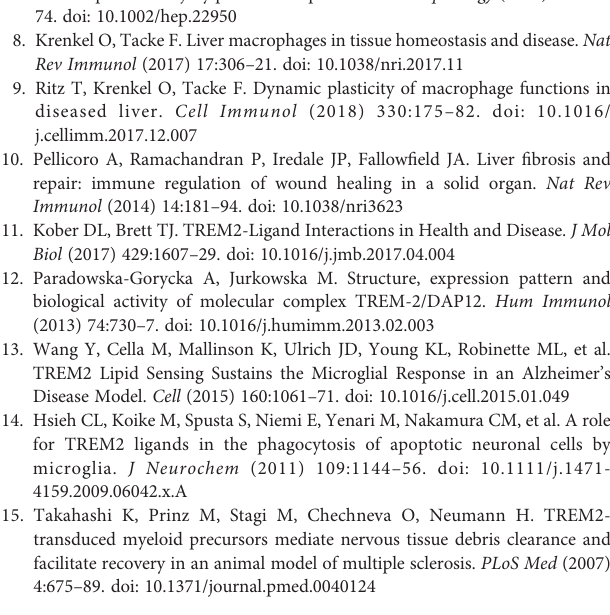
show enrichment in GFP+ cells compared to non-transferred mice in different macrophage populations: RLM, Transition and Kupffer cells. Supplementary Figure 4 | Accumulation of CD45neg SSChi cells correlates with expression of pro-in fl ammatory cytokines in the liver. Positive correlation between frequency of CD45neg SSChi population and TNF a gene expression in liver non- parenchymal cells during recovery from chronic injury (CCl4-D3). Statistics: Pearson ’ s correlation test. Supplementary Figure 5 | FACsort-puri fi ed macrophage populations and CD45neg SSChi cells for transcriptomic analysis. Wild-type and Trem-2 KO mice received a single intraperitoneal injection of APAP and macrophage populations and CD45neg SSChi cells were sorted at APAP-D3 and in control mice. Macrophage populationswereidenti fi edusingCD45,Ly6c,CD11bandF4/80markersandthepurity ofeachpopulationaftersortingisshown (A) . CD45neg SSChipopulationwas identi fi ed usingCD45markerinAPAP-D3andincontrolmiceandthepurityaftersortingisshown (B) . Each sample for transcriptomic analysis was obtained from pools of 4 mice. Supplementary Figure 6 | Heatmaps of DE-genes representing hierarchical clustering of macrophage and CD45neg SSChi cell populations. Heatmap represents 100 KCs associated genes42 for different macrophage populations (A) . Heatmap showingdifferentially expressed (DE) genes in CD45neg SSChi cells using KCs as reference: 821 genes upregulated in APAP-D3, 117 upregulated in control and 428 common to APAP-D3 and control as identi fi ed in Figure 2 .6A (B) . Supplementary Figure 7 | Gene expression and transcriptomic analysis of macrophage populations. Hmox1 and Fth1 gene expression was evaluated by qPCR in sort-puri fi ed KCs, transition and RLM populations from wild-type and Trem-2 KO mice at APAP-D3 (A) . Volcano plots representing differential expressed (DE)genes(q<0.05)between RLMandRHMinwild-typeandTrem-2KOmice.Red dots represent upregulated genes with LogFC>0, while blue dots represent downregulated genes with LogFC<0 signi fi cant for q<0.05 (B) . Venn diagram representing DE-genes between RLM and RHM which are common to wild-type and Trem-2 KO (middle), exclusive for wild-type (left) or Trem-2 KO (right). Gene Ontology (GO) enrichment analysis in the ‘ Biological Process ’ category for DE- genes in wild-type mice and Trem-2 KO mice (C) . Heatmap illustrating genes regulated by Trem-2 in transition macrophages. Log fold change (logFC) of genes previously associated to Trem-2 transcriptional signature (21, 22). Heatmap represents DE-genes upregulated in transition versus RLM at APAP-D3 in wild-type and Trem-2 KO